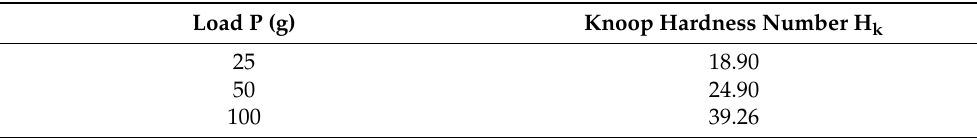
Table 6. Calculated Knoop hardness number for different loads of